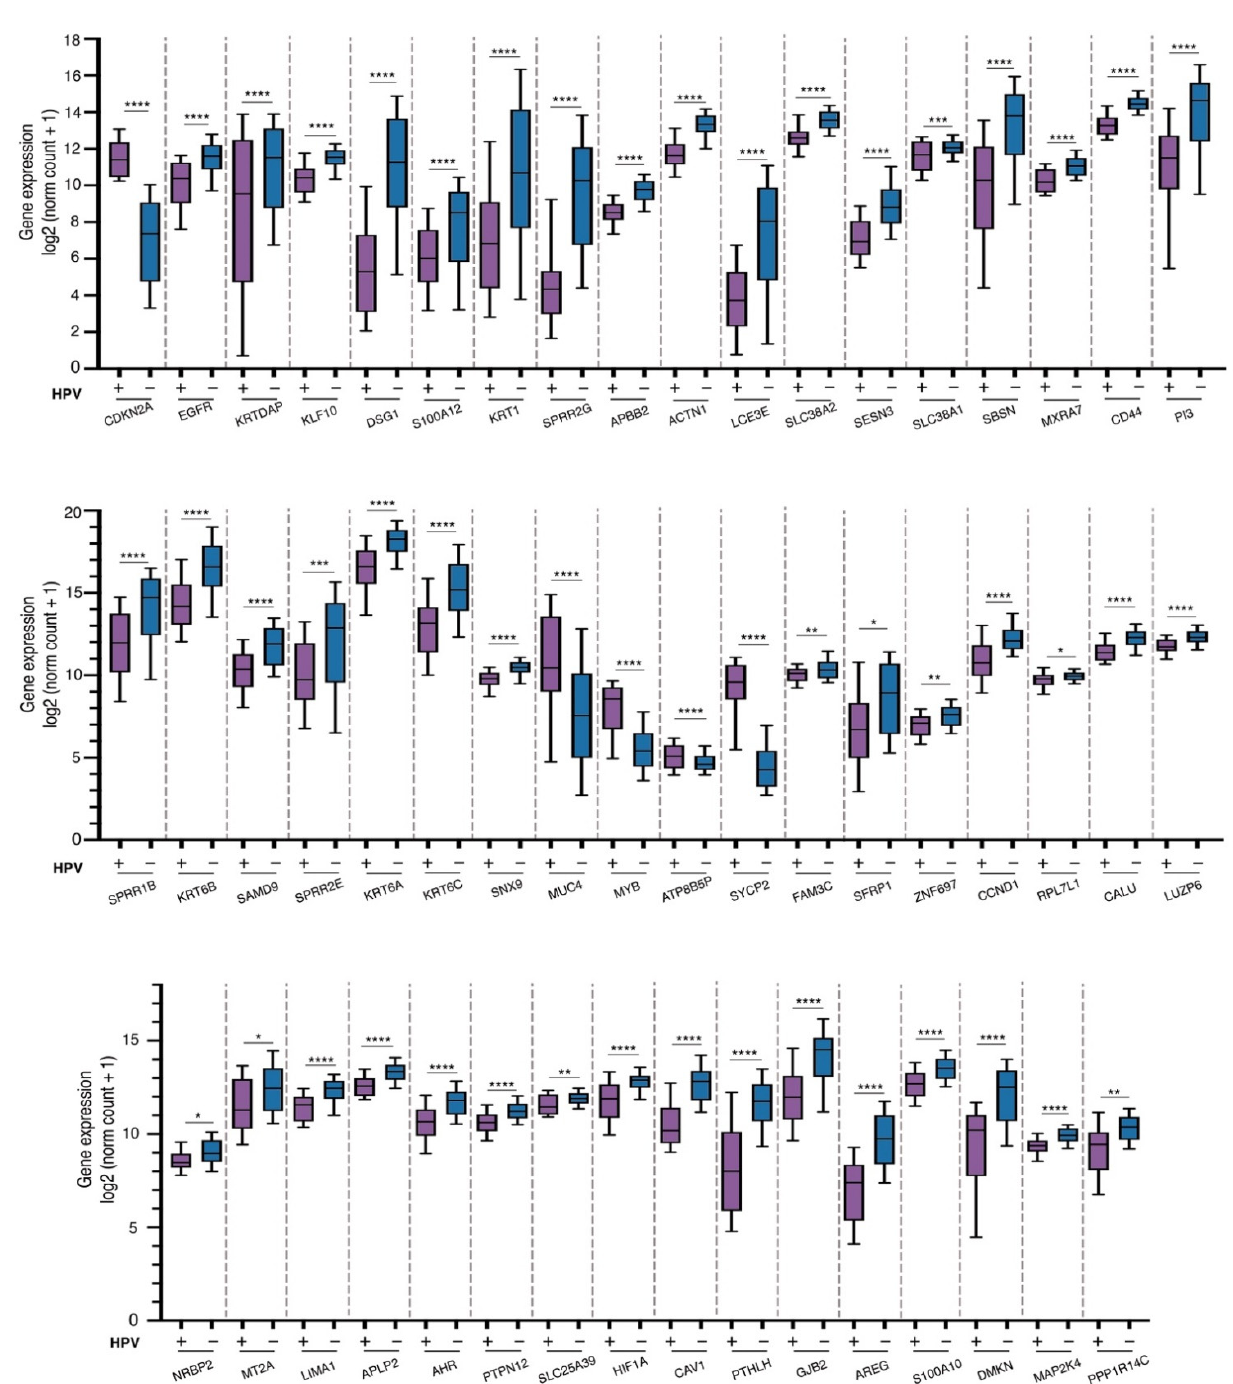
Figure 3. Expression profiles of differentially expressed mRNA validated in HNSCC samples from TCGA. Graph shows measure of expression profile of DE mRNA between HPV+ (purple) and HPV − (blue) tissues. Statistical analysis by Welch’s t -test (**** p < 0.0001, *** p < 0.001, ** p <0.01 and * p < 0.05).